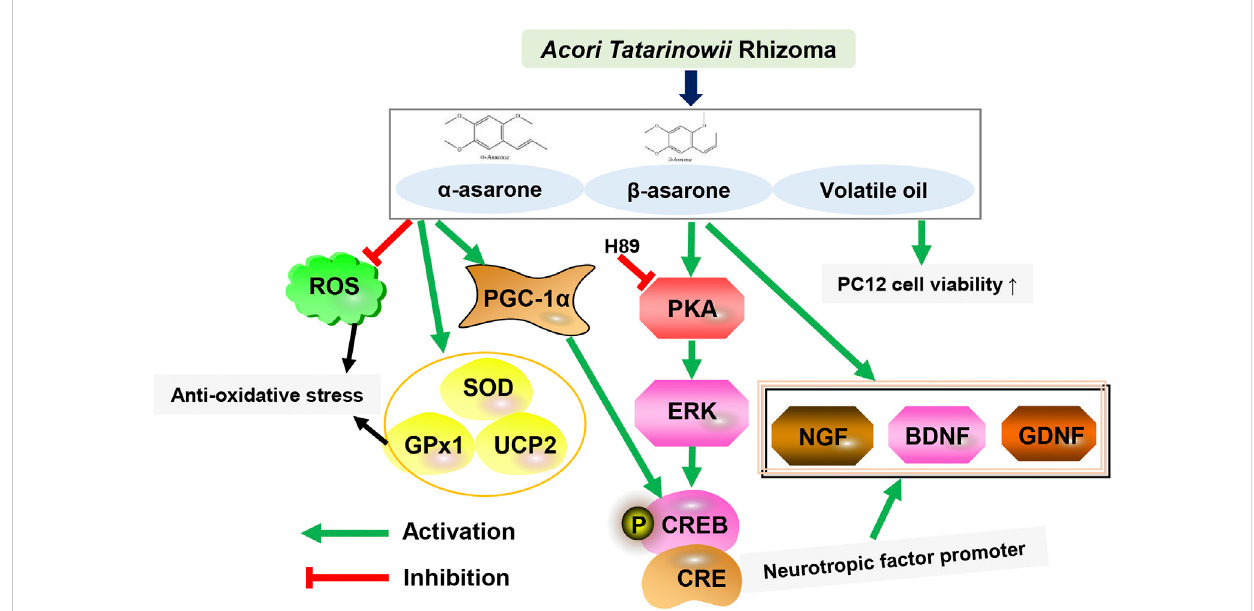
FIGURE 2 The main biological activities and potential mechanism of ATR on the central nervous